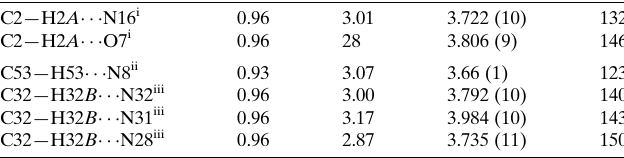
Table 2 Geometric parameters of intermolecular hydrogen bonds (A˚ , (cid:4)